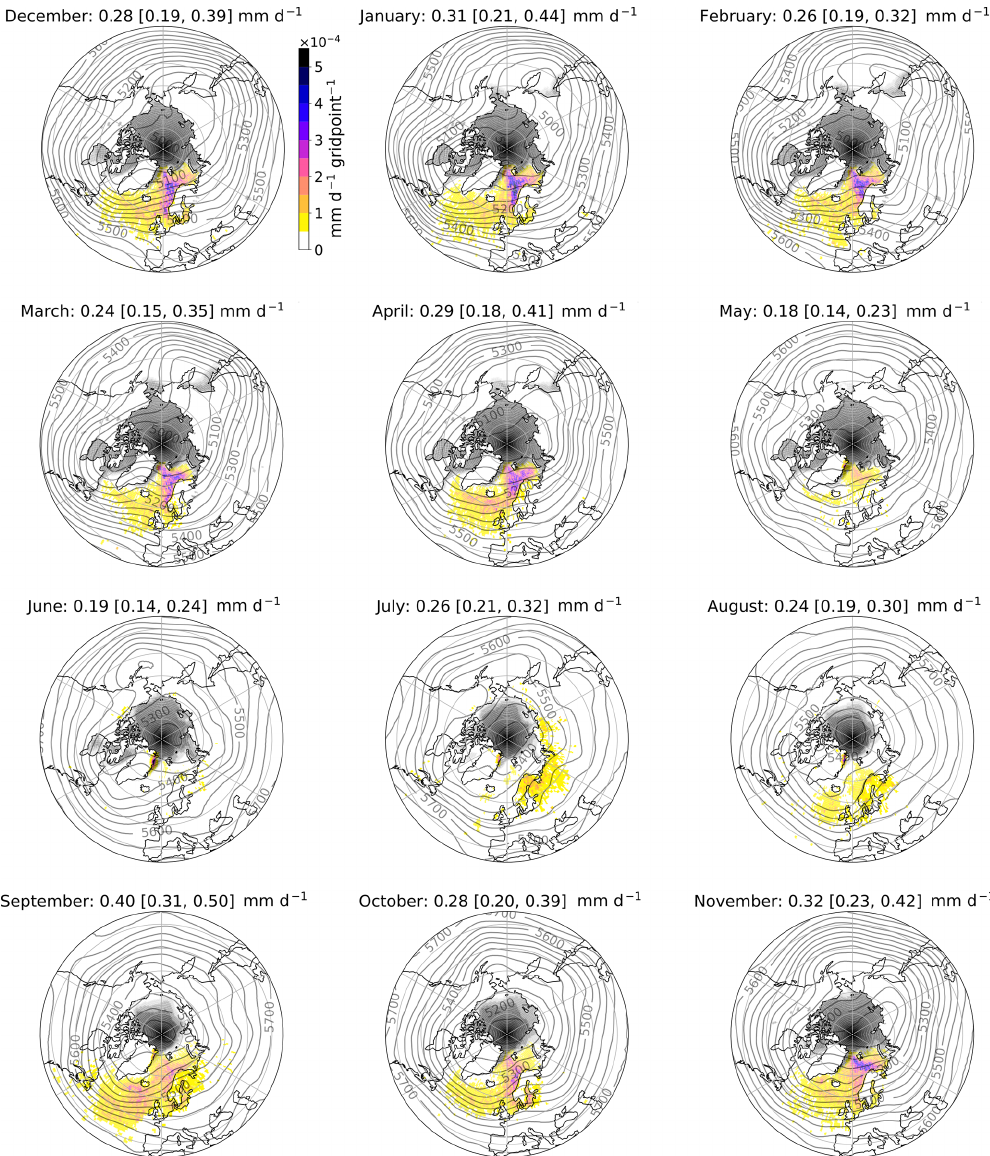
Figure 5. Annual cycle of mean monthly attributed moisture sources contributing to precipitation in study region over the period Febru- ary 1979–May 2017 (grid points coloured after their contribution between 35–90 ◦ N, contributions < 3% further southward). The mean sum of moisture sources over all grid points (i.e. accounted precipitation) is given for each month with its 95% confidence interval and is only a part of the total precipitation (Fig. 4). Mean 500hPa geopotential height (grey lines) and mean ice area cover (grey shaded area) are